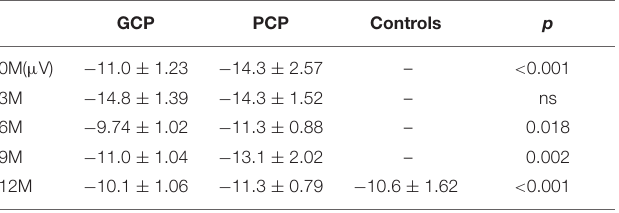
TABLE 2A | The N1 amplitude across the groups.